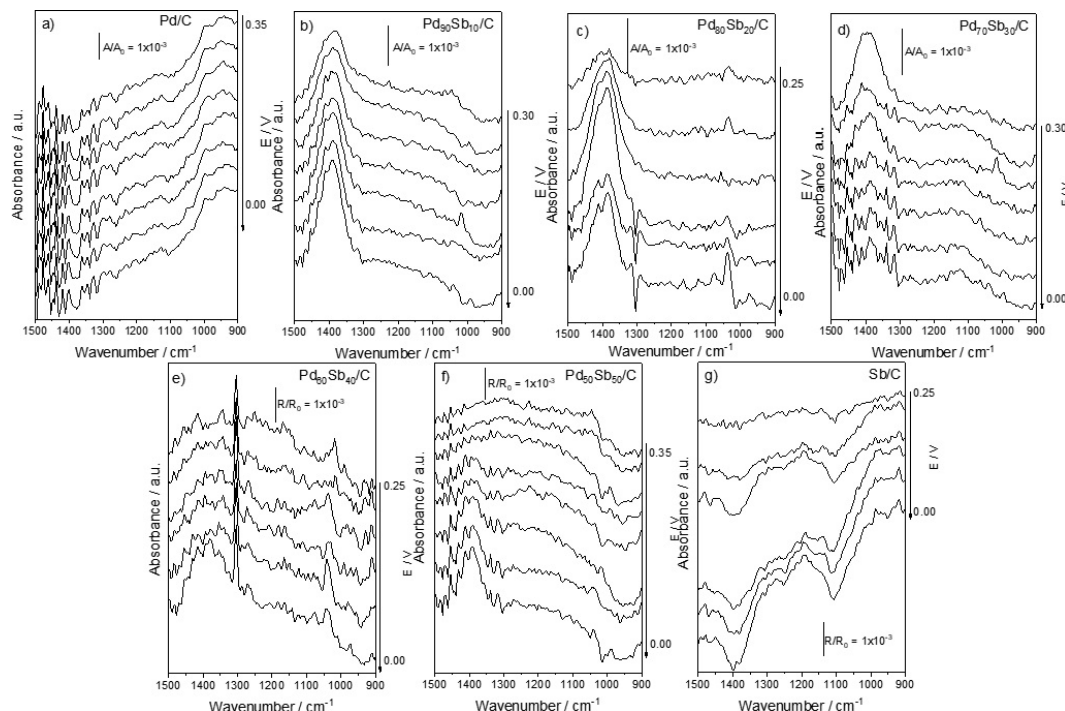
Figure 7. FTIR spectra were taken from effluent of SER-FC at several potentials in 1.0 mol.L -1 KOH and the methane flow was set to 50 mL.min -1